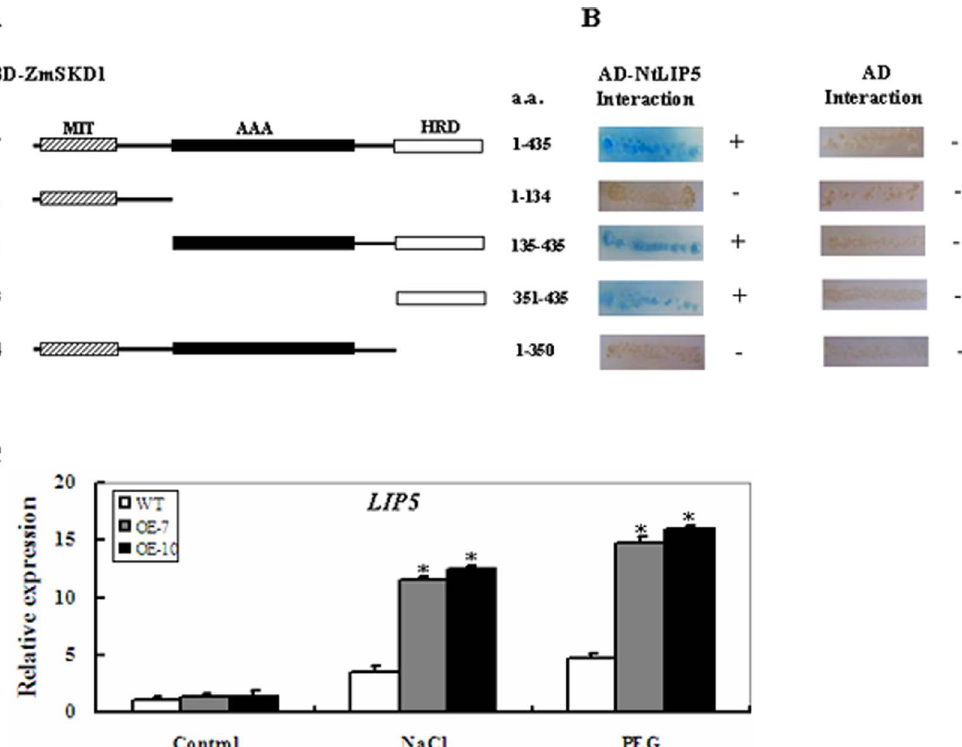
Figure 7. Mapping of the ZmSKD1 region involved in SKD1-LIP5 interaction and transcript levels of NtLIP5 in responses to salt or PEG-induced water stress in transgenic and wild-type plants. A Schematic representation of wild type (WT) and mutant SKD1s in the study. M1 and M4 are C-terminal deletion mutants, and M2 and M3 are N-terminal deletion mutants. MIT marks microtubule-interacting and trafficking; AAA marks ATPase associated with a variety of cellular activities; HRD marks the a -helix-rich domain located at the C-terminus of SKD1. The numbers denote SKD1 amino acid positions. B The interaction between LIP5 or empty vector pGAD-T7 and SKD1 deletions in YTH assays. The ability of SKD1 truncations to interact with LIP5 or AD vector is indicated on the right ( + , positive; 2 , negative). C NtLIP5 transcript levels under salt or PEG-induced water stress in transgenic and wild-type plants. Four-week-old transgenic and wild-type tobacco plants were exposed to distilled water (control), 15% PEG6000 and 200 mM NaCl for 12 h, respectively, and leaf samples were used for real-time PCR analysis. NtActin was used as an internal control. For each treatment, the expression level under control conditions was defined as 1.0, and data represented means 6 SE of three technical replicates. *t- test, with P ,